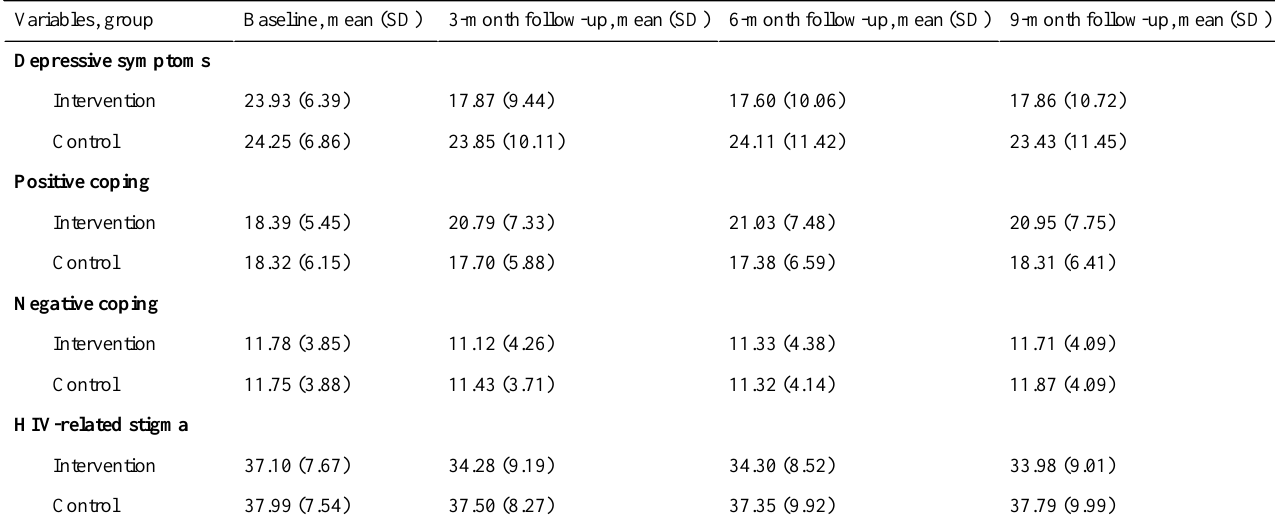
Table 2. Repeated measurements of depressive symptoms and potential mediators in the Run4Love randomized controlled trial.